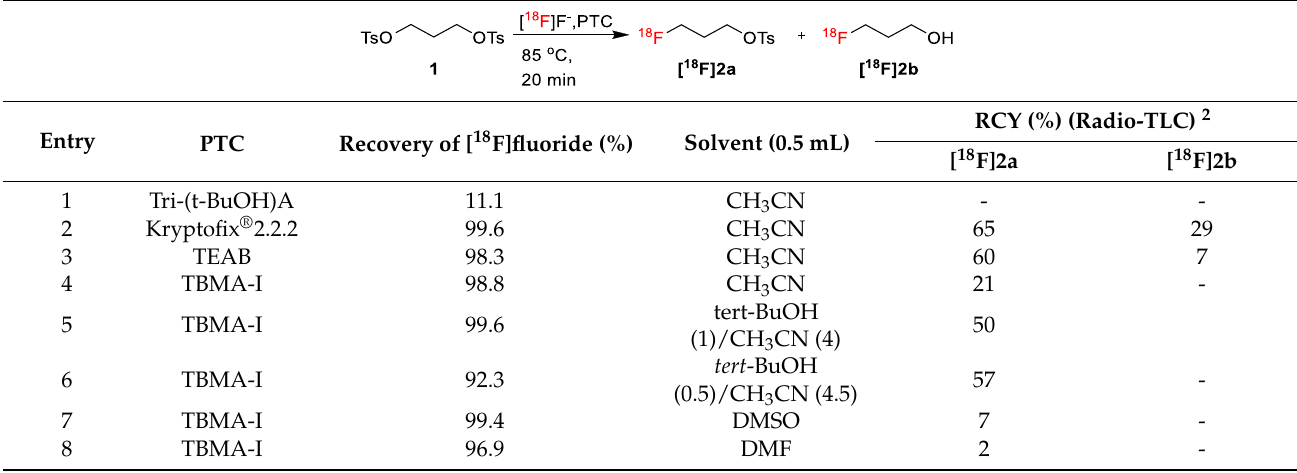
Table 2. Reactivity of tert -alcohol-functionalized amines as PTCs for the 18 F-substitution of 1,3-ditosylpropane ( 1 ) using various reaction solvents 1 .